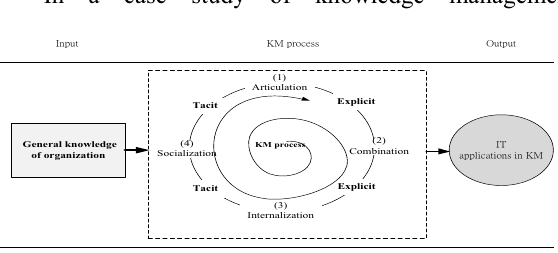
Fig. 1. KM transformations